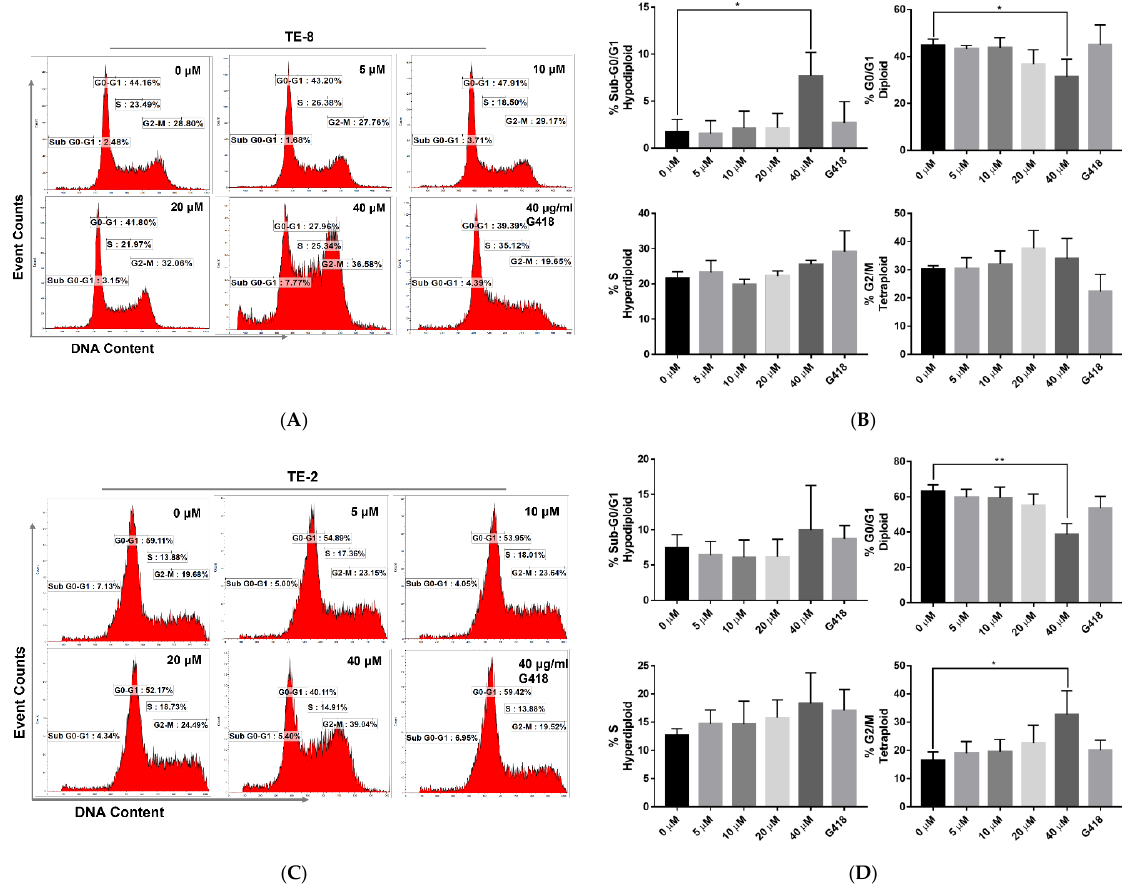
Figure 3. Oridonin disturbs the cell cycle of TE-8 and TE-2 ESCC cell lines. ( A ) Oridonin induces apoptotic DNA fragmentation (sub-G0/G1 phase) associated with reduced G0/G1 value in a dose- dependent manner on TE-8 cells after 24 h treatment. ( B ) Under 40 µM oridonin treatment on TE-8 cells, the sub-G0/G1 phase was significantly increased (1.68% vs. 7.68%) while the G0/G1 phase was markedly reduced (44.76% vs. 31.29%) compared to the control. ( C ) Oridonin reduced G0/G1 value and arrested the G2/M phase on TE-2 cells after 24 h treatment. ( D ) Under 40 µM oridonin treatment on TE-2 cells, the G0/G1 phase was significantly diminished (63.23% vs. 38.78%) while the G2/M phase was markedly arrested (16.43% vs. 32.60%) contrary to the control. Results are presented as mean + SEM from three independent experiments. The 0.08% dimethyl sulfoxide (DMSO) in the complete medium labeled as 0 µM was the negative control. The G418 treatment was a positive control. (* p < 0.05, ** p < 0.01).